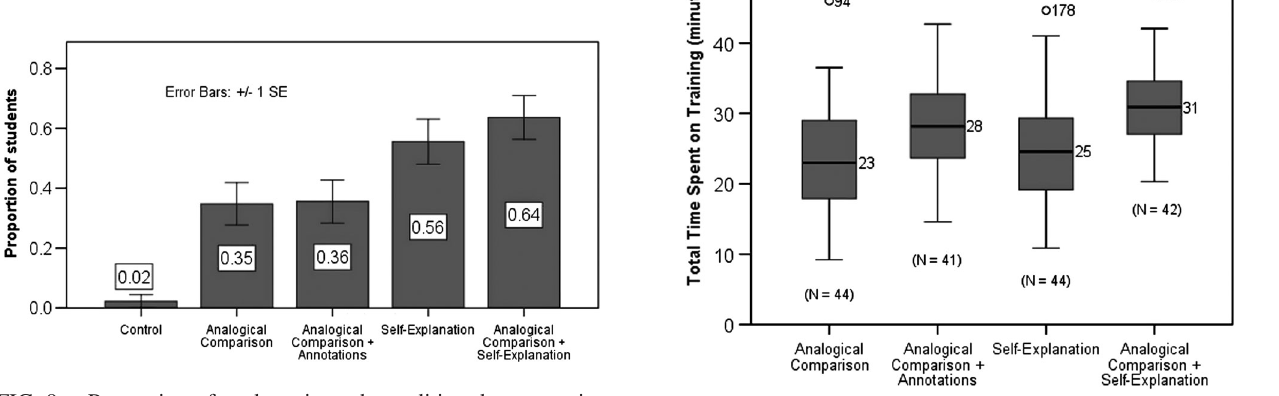
FIG. 10. Box plot of student time spent on training by